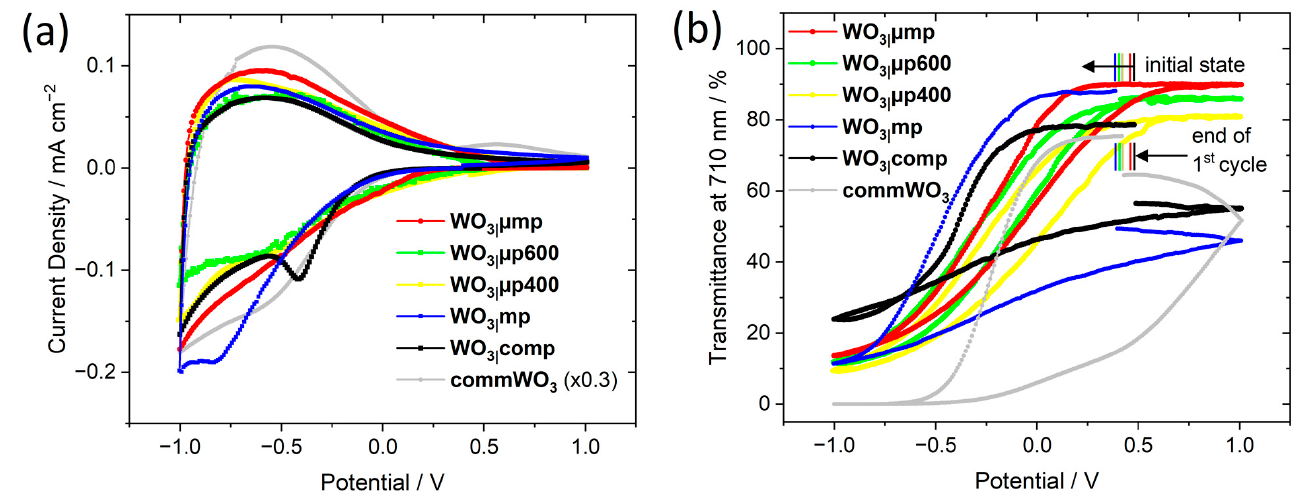
Figure 6. CV of the first cycle at a scan rate of 5 mV s − 1 ( a ) and transmittance at 710 nm ( b ) in dependence of the applied potential during the CV of thin films of WO 3| comp (black), WO 3| µp400 (yellow), WO 3| µp600 (green), WO 3| mp (blue) and WO 3| µmp (red) as well as commWO 3 (grey) in LiClO 4 in PC. The initial states of each sample are marked by vertical lines and the arrows indicate the direction of cycling. Table 6. Reversibility of the electrochromic switching determined from the first ( K 1 ) and second ( K 2 ) cycle of the CV measurements at a scan rate of 5 mVs − 1 measured for at least 2 specimens of a given kind (commWO 3 only measured once).